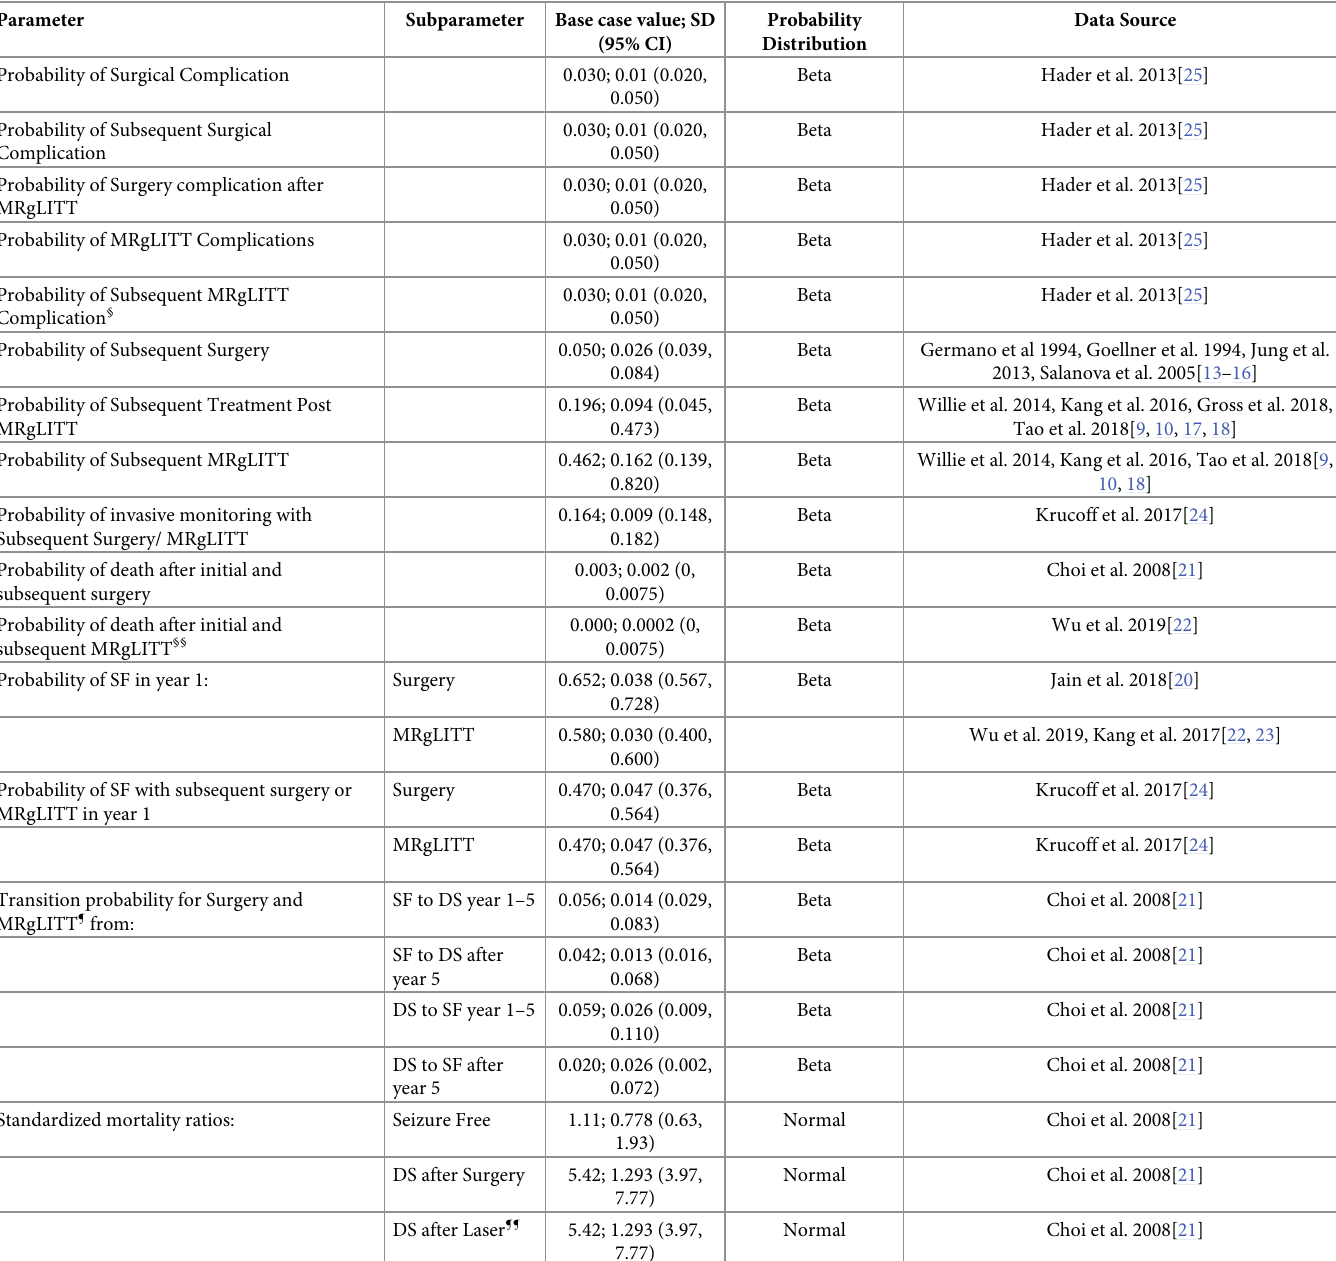
Table 1. Probability parameters for